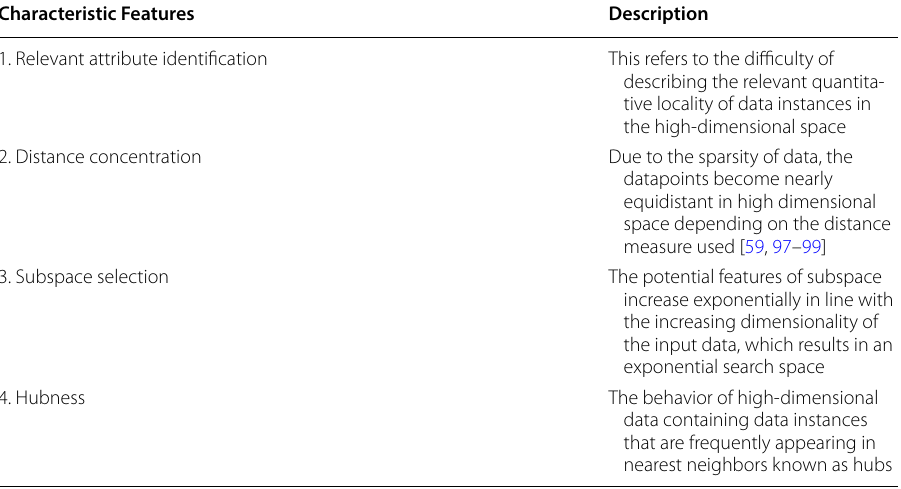
Table 3 Challenges of anomaly detection in context of high dimensionality problem Characteristic